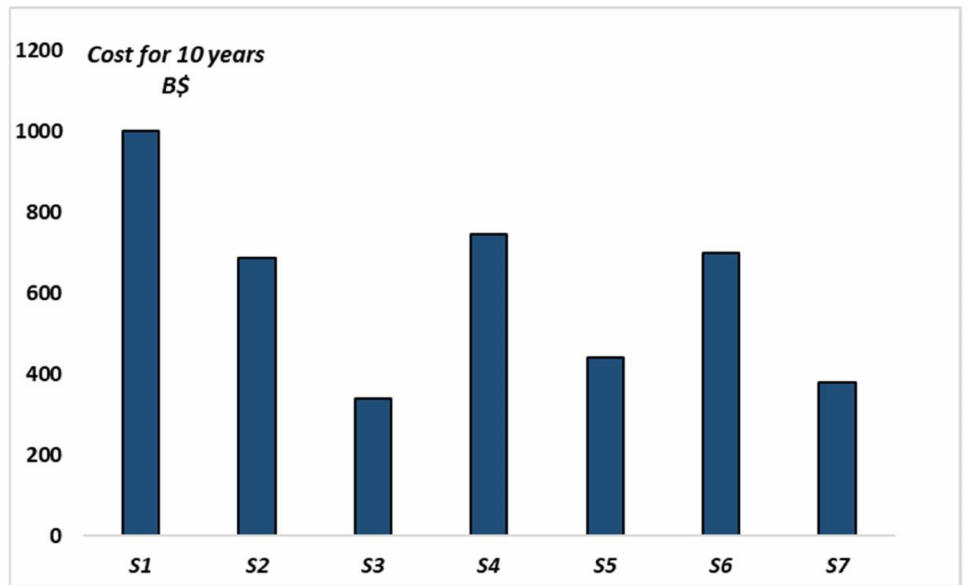
Figure 5. Various penetrations of ERS by the electricity and fuel costs, based on the year